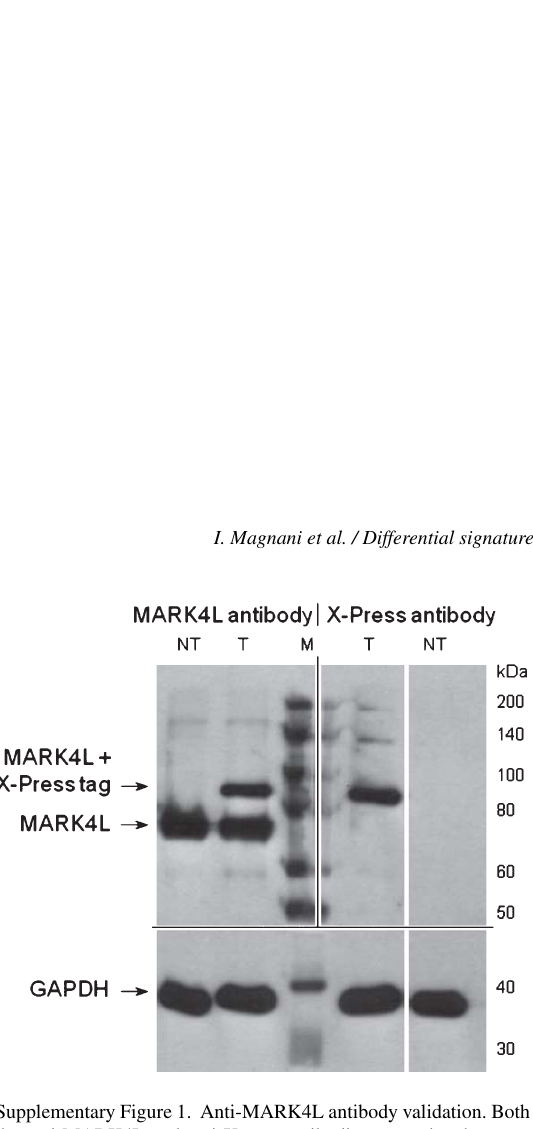
Supplementary Figure 1. Anti-MARK4L antibody validation. Both the anti-MARK4L and anti-Xpress antibodies recognise the over- expressed MARK4L protein in immunoblotting experiments. HEK293T cells were transfected with plasmid DNA encoding the fusion protein MARK4L+Xpress tag. The anti-MARK4L antibody stainstheendogenousMARK4Lprotein(lowerband)andthefusion protein (upper band), whose higher molecular weight is due to the Xpresstagandthehistidinetail.Themembranewascut(blacklines) after the blocking step and incubated with the appropriate antibod- ies. NT, non-transfected HEK293T cells; T, transfected HEK293T cells; M, molecular weight ladders